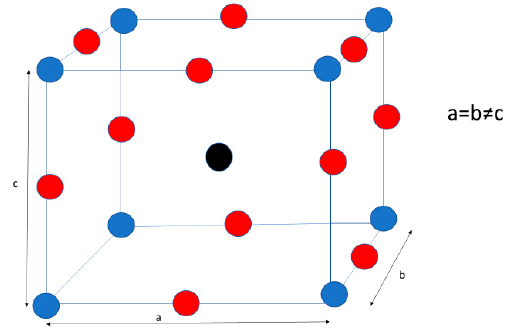
Figure 1. Tetragonal phase of a perovskite structure.